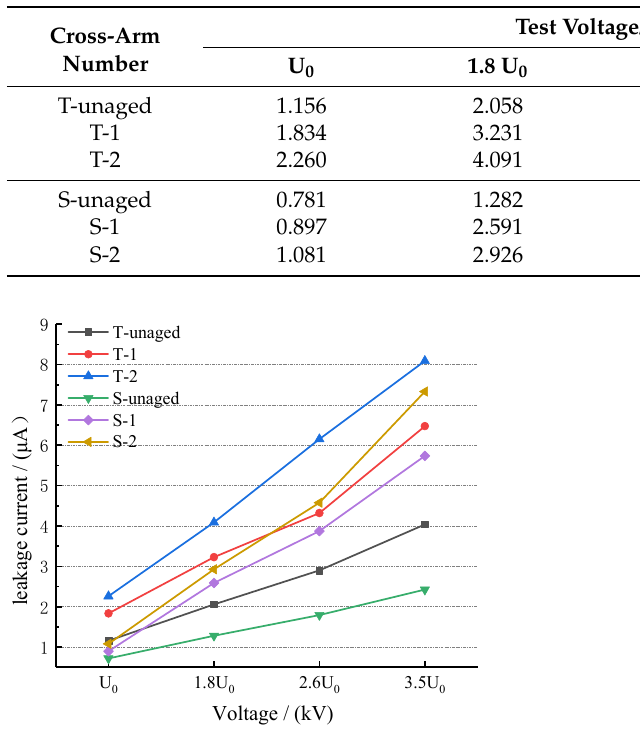
Figure 4. Variation of leakage current of composite cross-arms with different aging factors with applied voltage. Table 6. Leakage current of the composite cross-arms with different aging types.